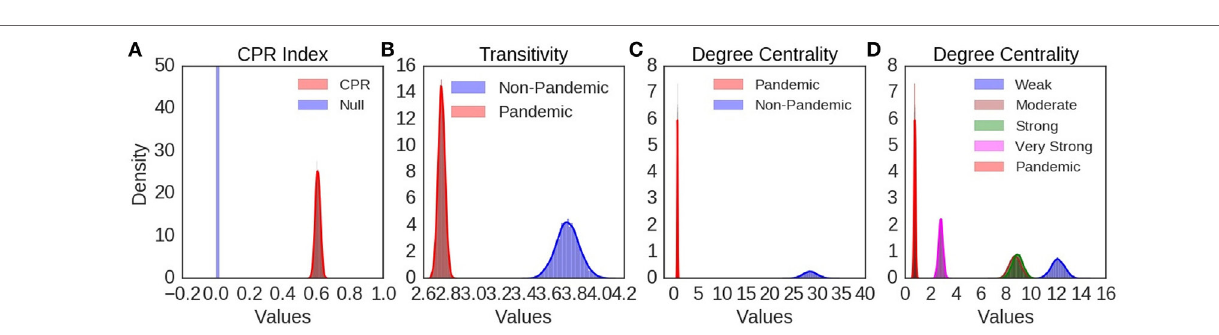
FigUre 7 | The distribution of bootstrap statistics is shown in (a) for cross correlation index (CPR), in (B) for transitivity, in (c) for degree centrality during El Ninos with pandemic and those without pandemic, and in (D) for degree centrality for El Ninos of different strength. The distribution of bootstrap statistics shows very highly significant statistical differences compared with random time